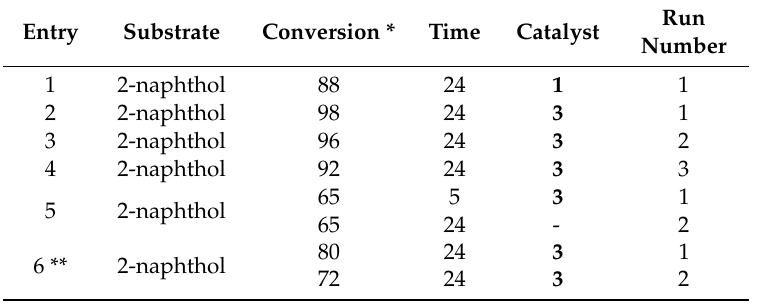
Table 2. Acylation of O–substrates with Ac 2 O in the presence of 1 and 3 as